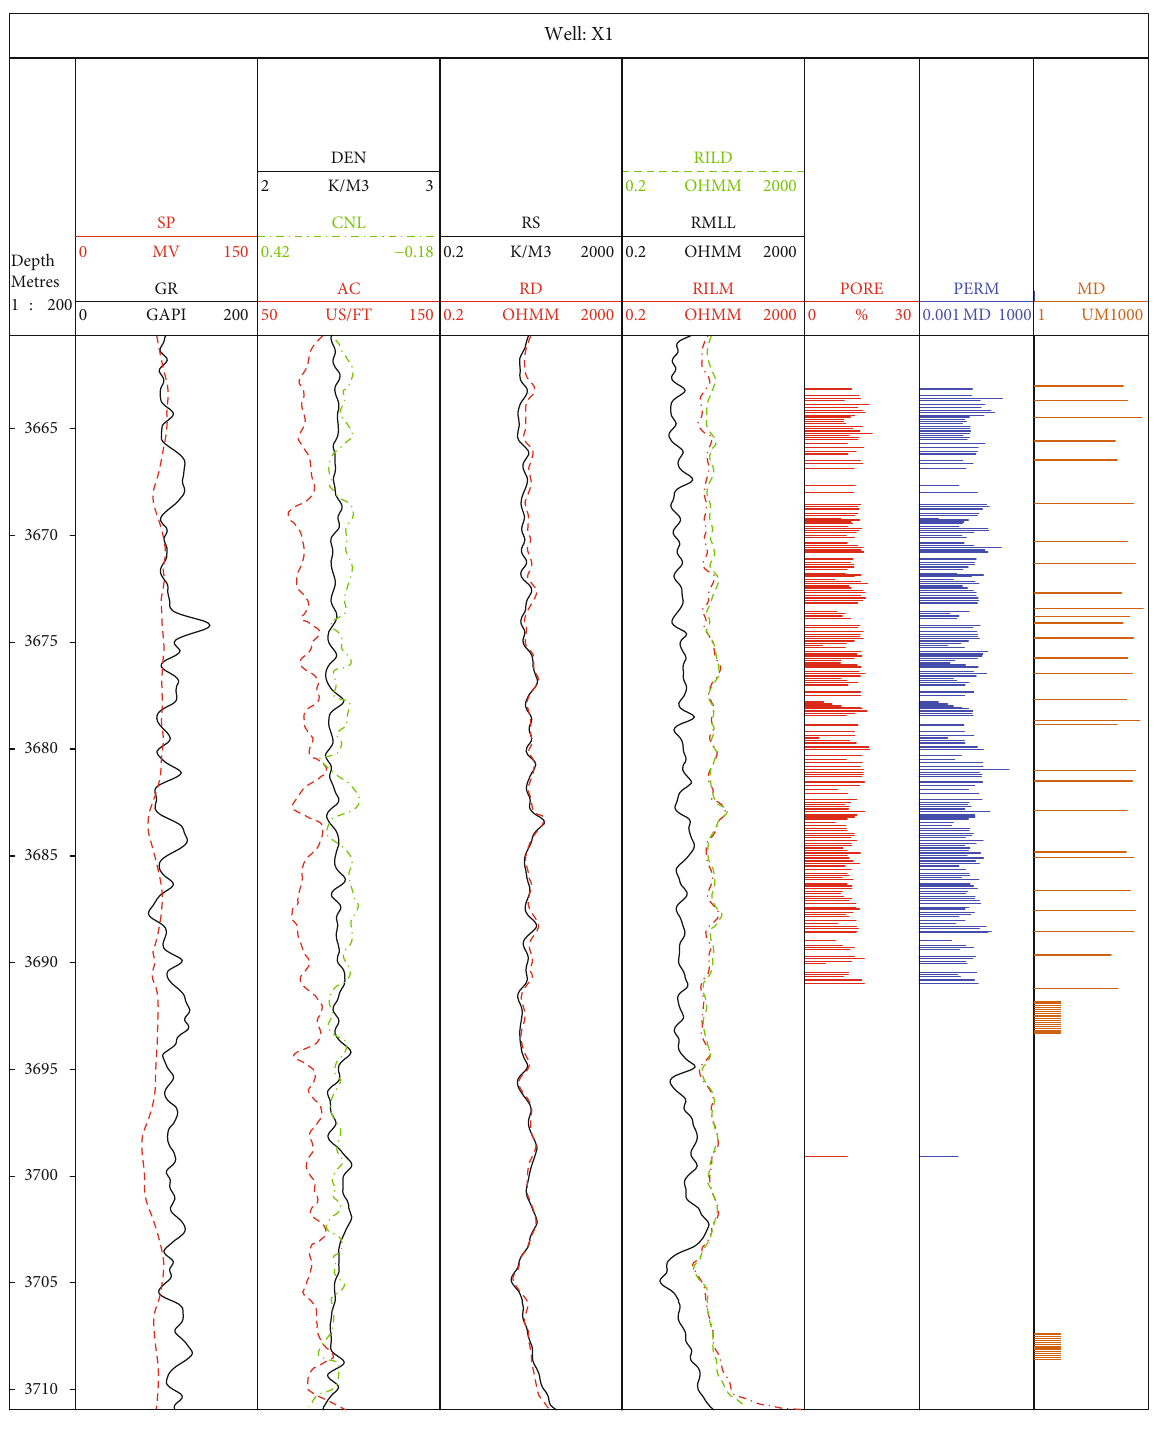
section of well 3